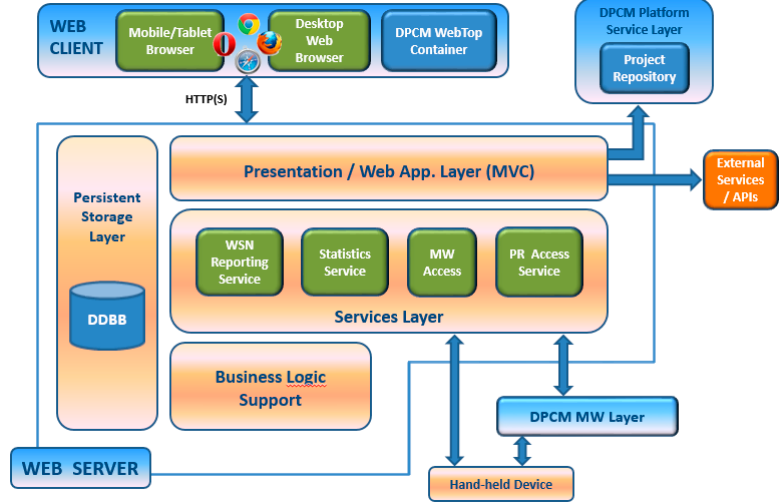
Figure 21. Overall software architecture and interfaces of the Commission and Maintenance Tool server component.